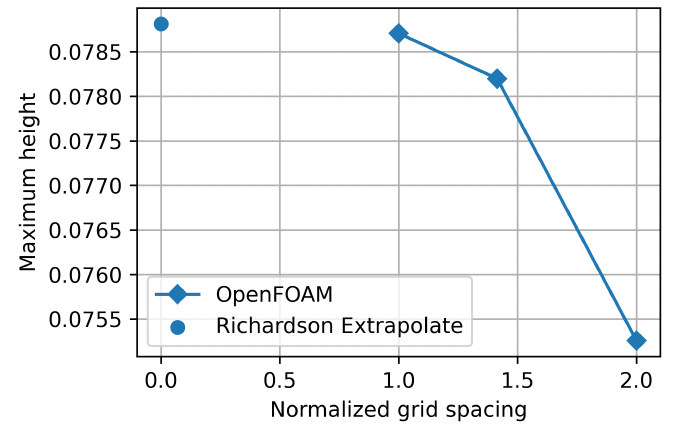
Figure 3. Maximum surface elevation for the three grids tested at zero grid spacing, using Richard- son’s extrapolation method.